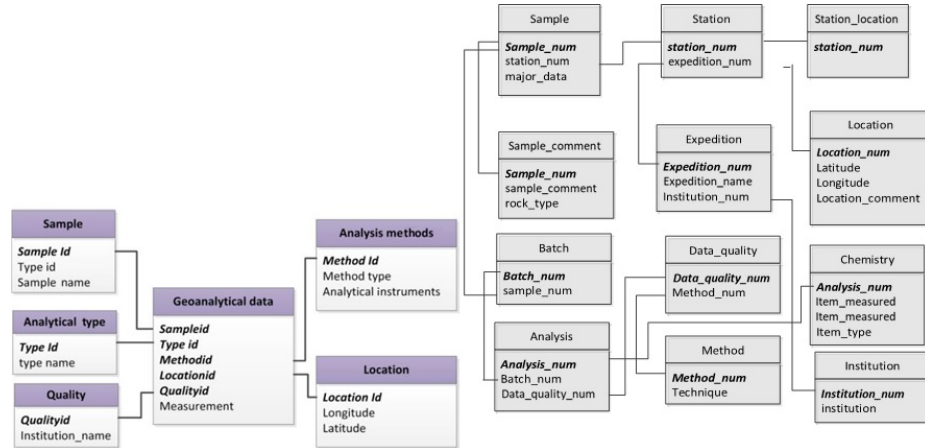
Figure 5. Physical data model (PDM) structure comparison with the Lehnert rock data model.